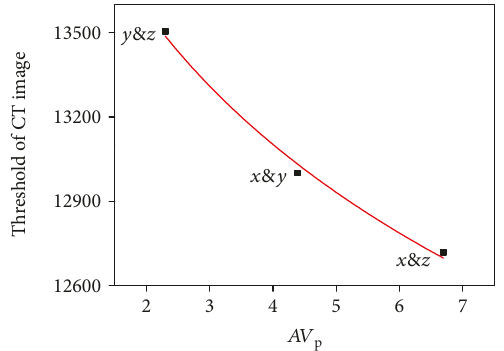
V P and S of coal samples.